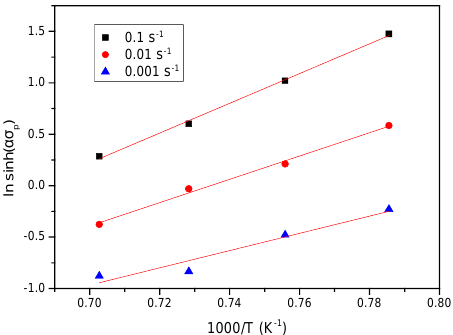
Figure 6. The linear relationship between ln(sinh𝛼𝜎 𝑝 ) and 1/T.